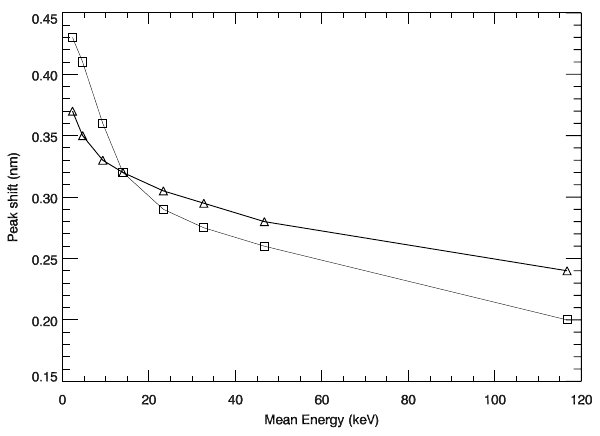
Fig. 2. Dependence of peak shift from the rest line wavelength for simulated (squares) and convolved (triangles) synthetic H- β line profiles on the mean energy of precipitating protons.